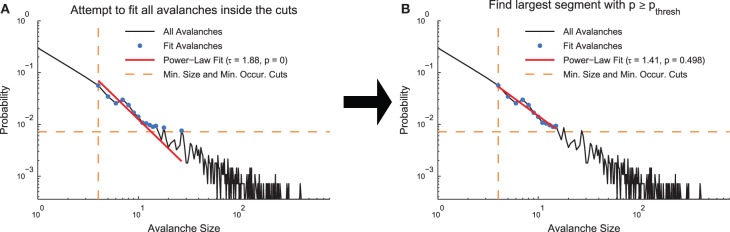
Power-law fit search algorithm. (A) A MLE fit is performed on the avalanches after minimum size or duration cuts and occurrence cuts are applied. (B) If the p < pthresh in (A), progressively smaller ranges of avalanche sizes or durations are fit until p ≥ pthresh. The data for this explanatory diagram was taken from the cortical branching model.